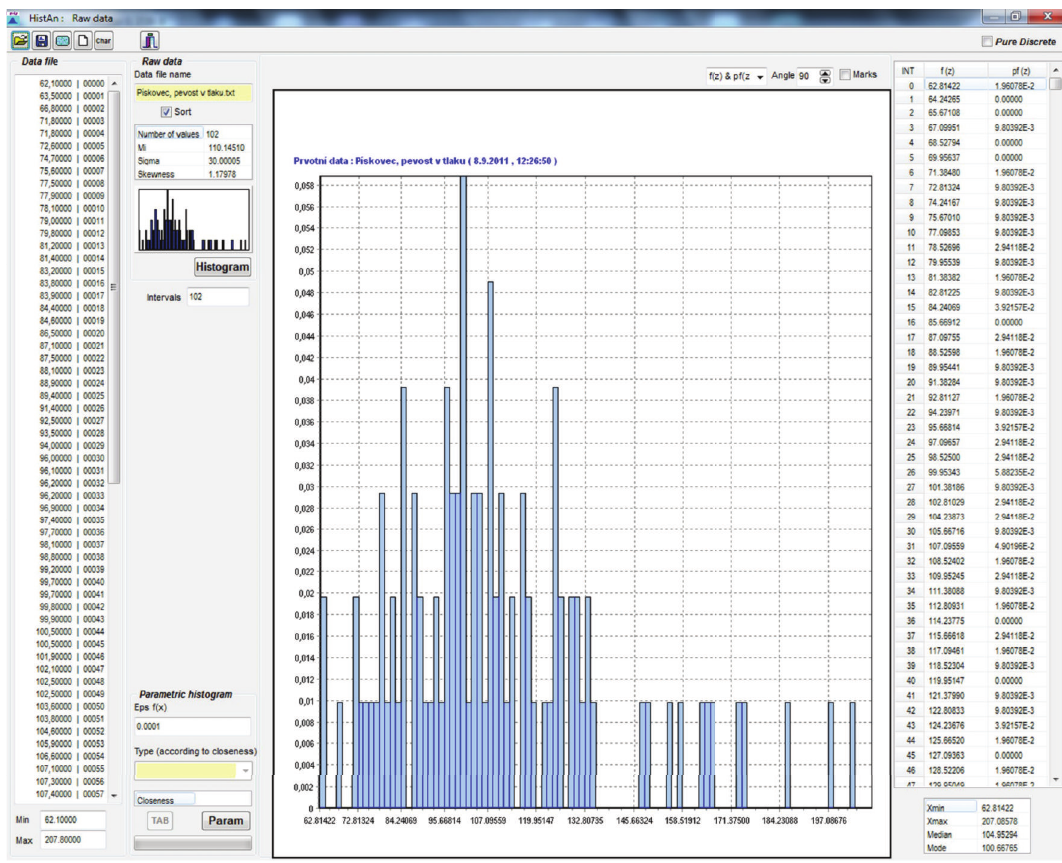
Figure 5: Histogram with empirical distribution of probabilities created from measured compression strength in carboniferous sandstone